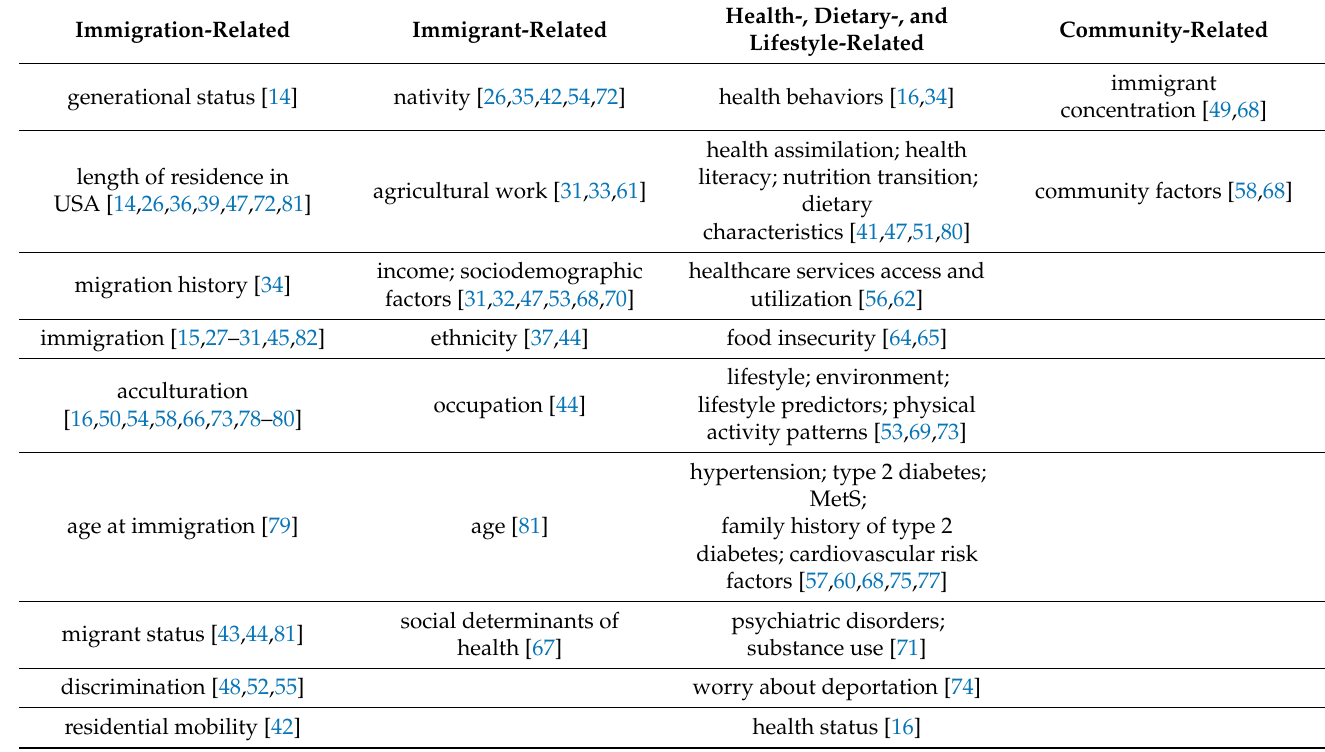
Table 1. Exposures Assessed in Studies